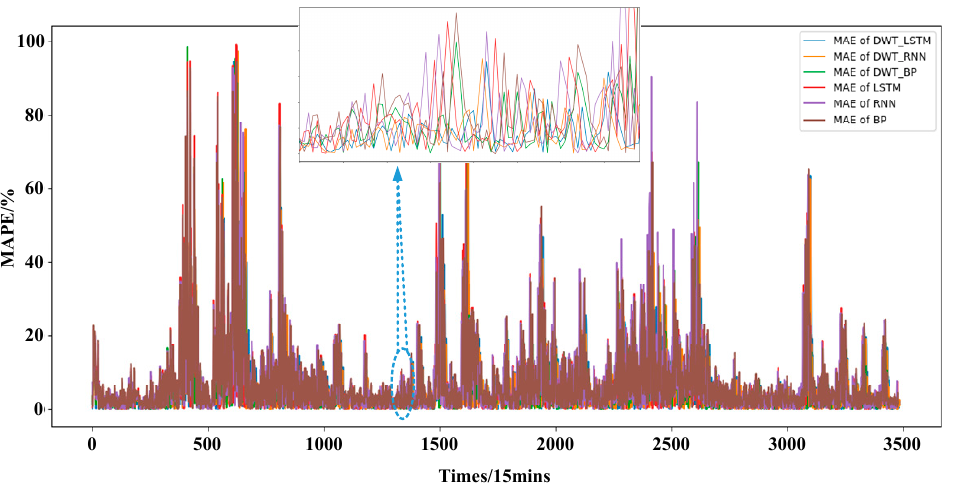
(a) MAPE of one-step forecasting based on six methods for farm 1.